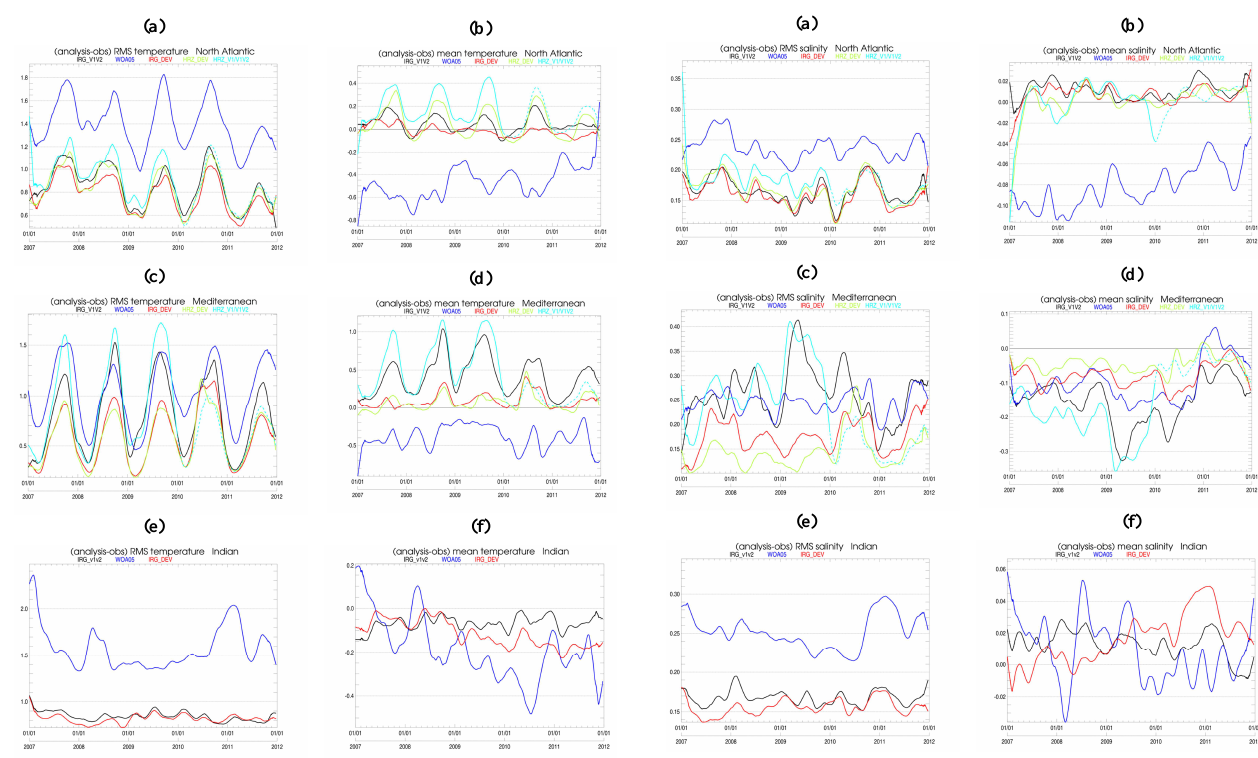
Fig. 7. Temperature (°C) RMS ( a , c and e ) and mean ( b , d and f ) differences (analysis minus observation). For these diagnostics, all available T/S observations from the CORIOLIS database and Mercator Océan daily average analyses, collocated (temporally and spatially) with observations, are used. Statistics are displayed for IRG V1V2 (black line), IRG DEV (red line), HRZ V1 (cyan solid line), HRZ V1V2 (cyan dashed line), HRZ DEV (green line) and World Ocean Atlas climatology WOA05 (blue line). Averages are performed in the 5–100m layer in the basin-scale zones of the North Atlantic ( a and b ), Mediterranean Sea ( c and d ) and Indian Ocean ( e and f ).